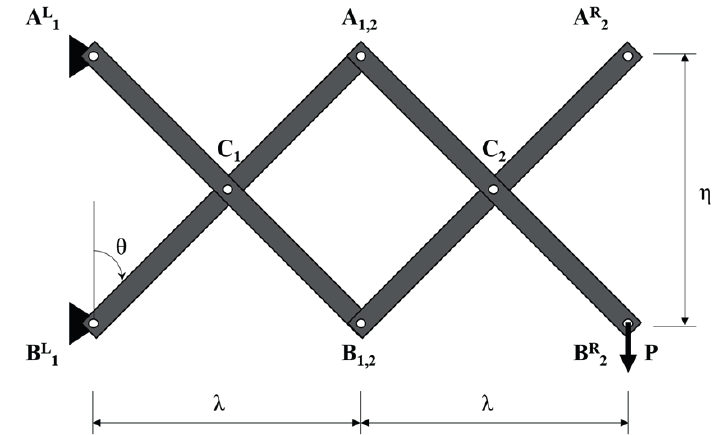
Figure 5. Two-units scissors structure by cantilever